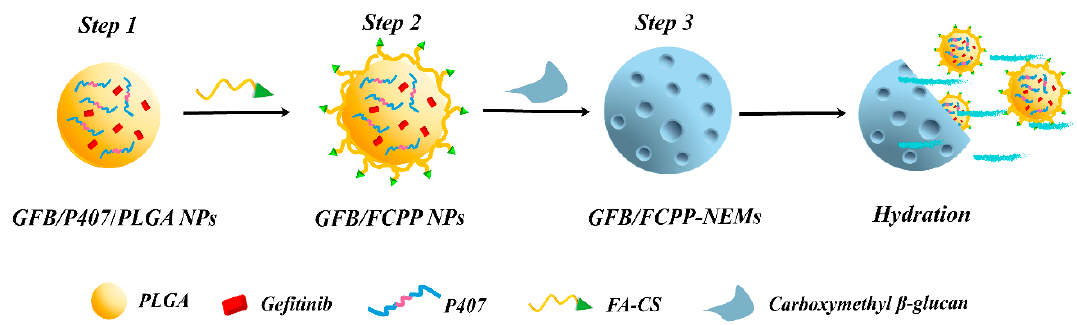
Figure 1. Schematic diagram of the preparation of gefitinib-loaded and folic acid (FA)-conjugated chitosan (CS)-coated poloxamer 407 (P407) / poly (lactic-co-glycolic acid) (PLGA) nanoparticles (NPs), namely GFB / FCPP NPs and GFB / FCPP NPs embedded in microcapsules (MCs), namely GFB / FCPP- NEMs.